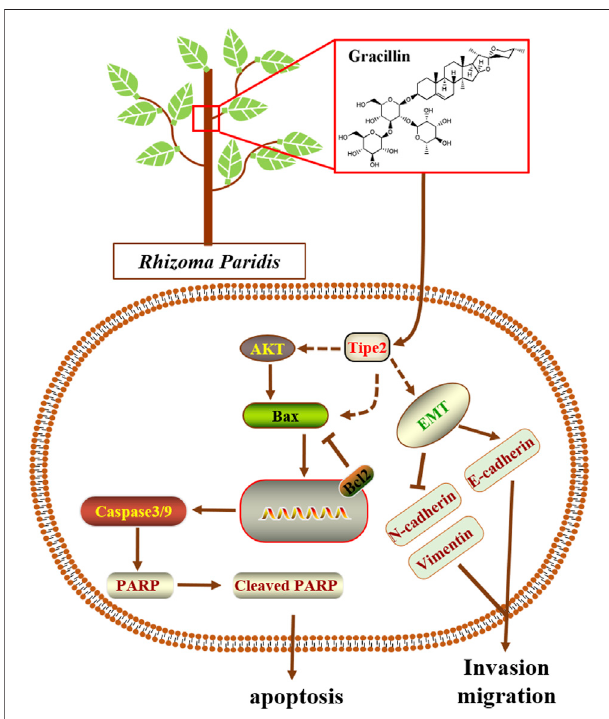
FIGURE 9 | Scheme summarizing the mechanism of gracillin suppress gastric cancer via TIPE2.